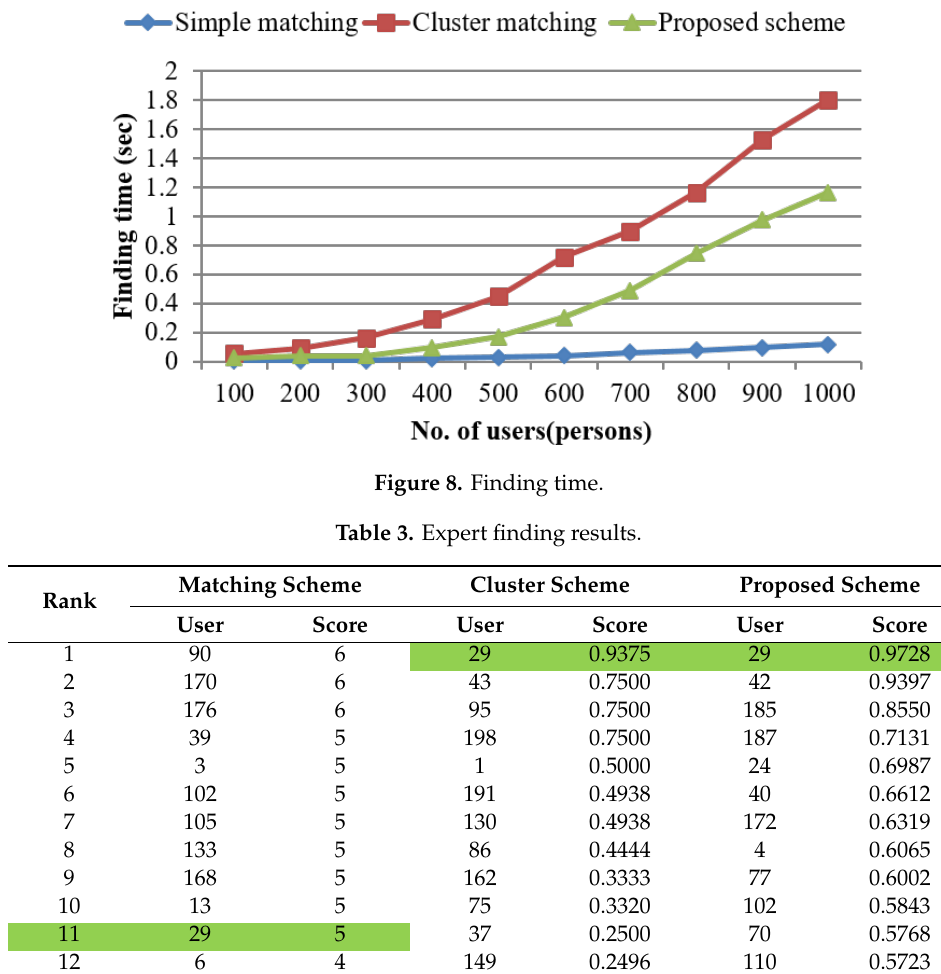
Table 2. Performance evaluation environment. Parameter